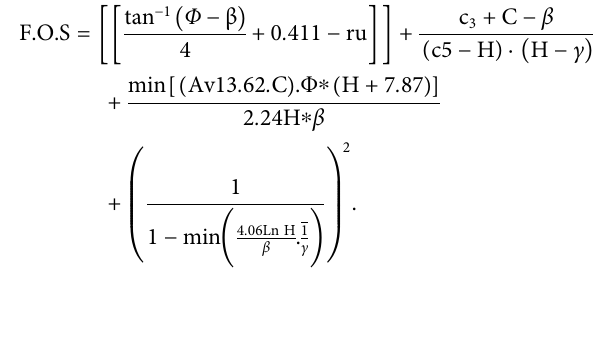
( γ ), overall angle slope (), slope height (H), and pore water ratio